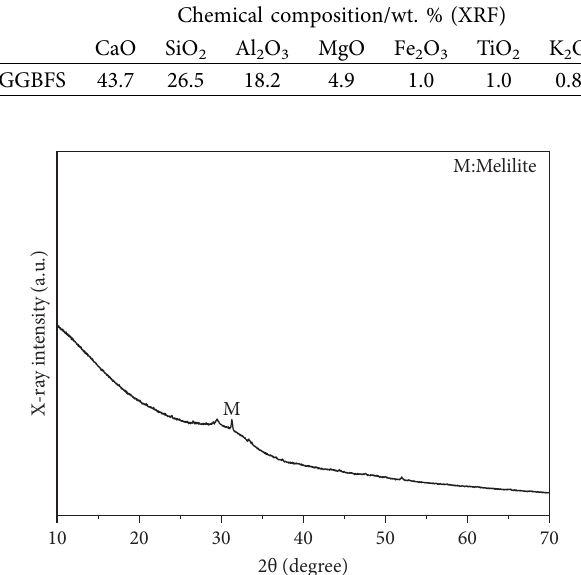
Table 1: Chemical composition of GGBFS.